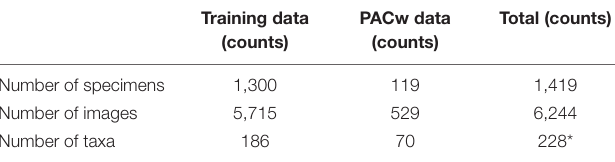
TABLE 2 | Details of the image data